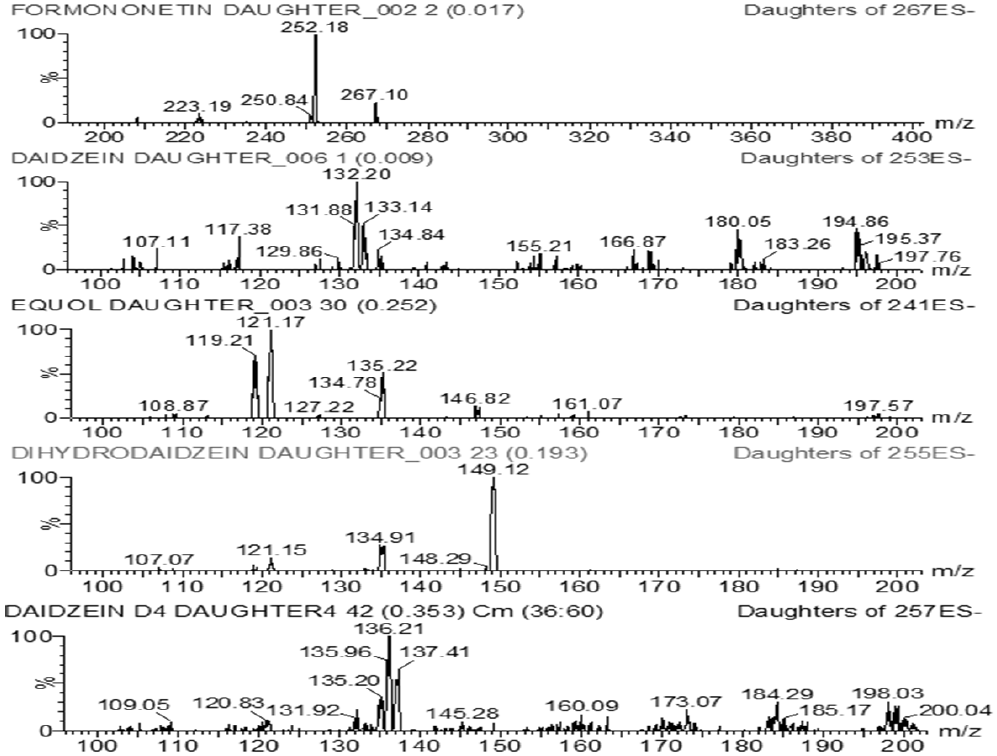
Figure 2. The product ion scan spectra with chemical structures of FMN, DZN, EQL, DHD, and IS.